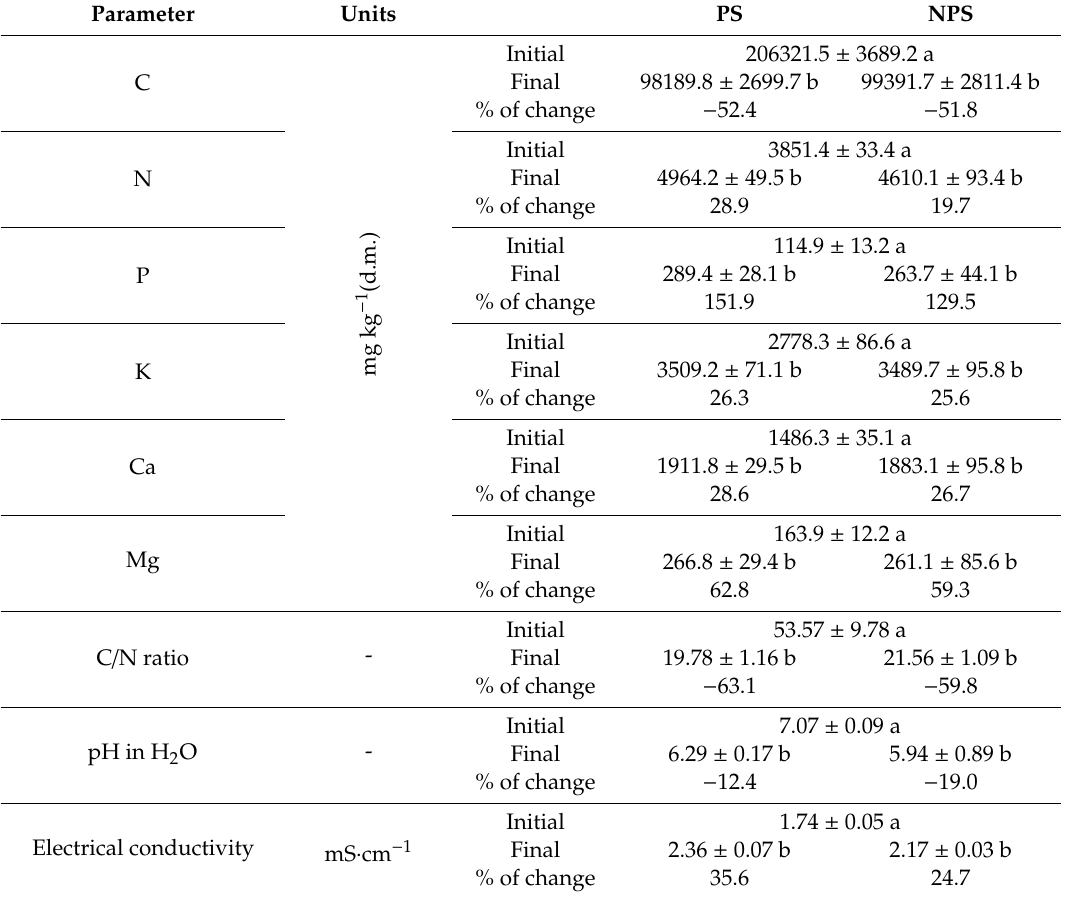
Table 3. Content of macronutrients in sugar beet pulp and obtained vermicomposts.